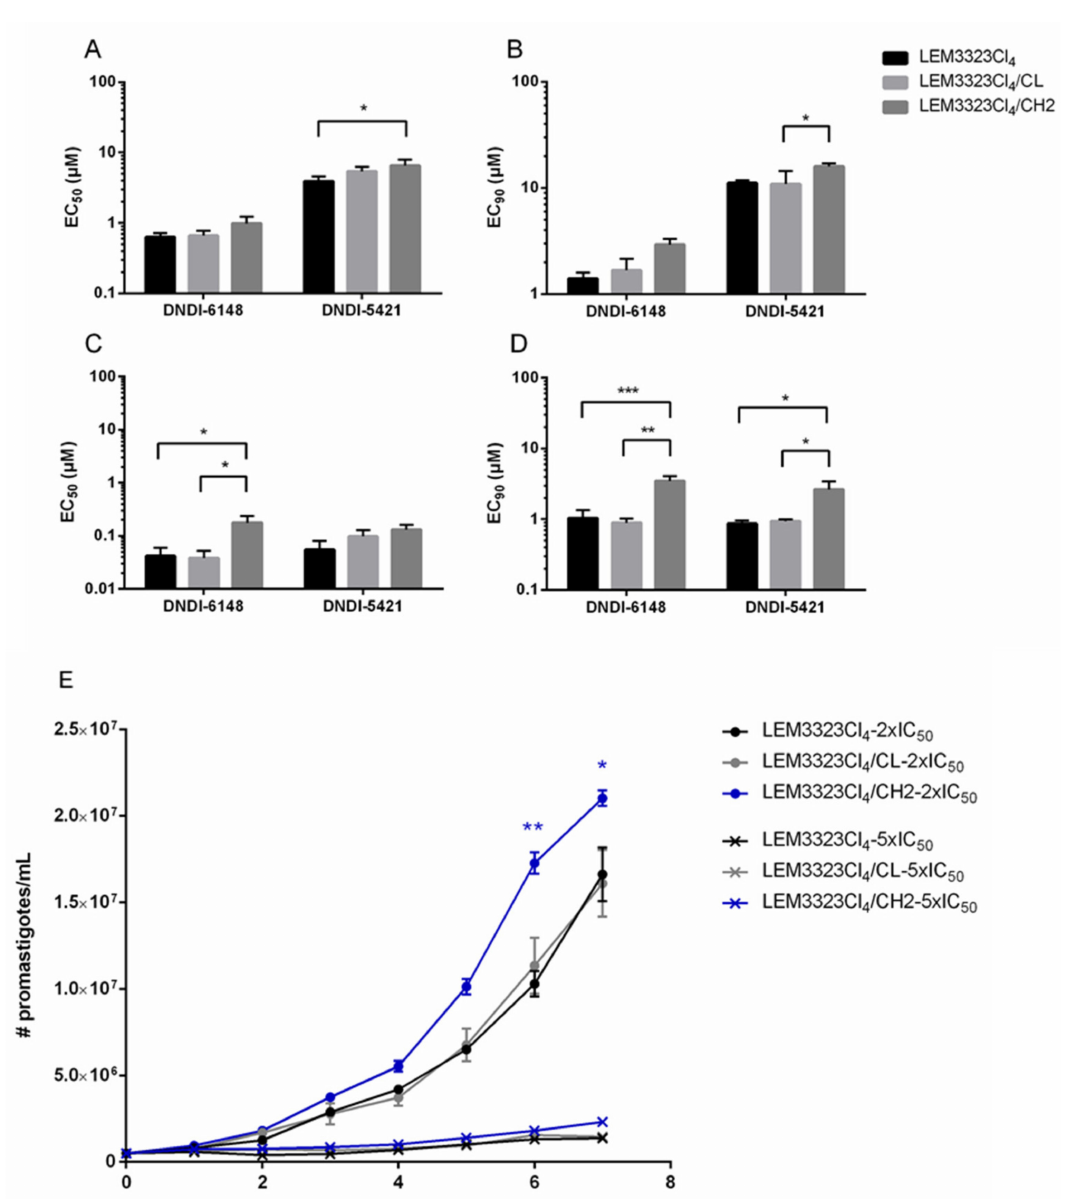
Figure 4. Susceptibility and growth curves of strains harboring either the empty cosmid (LEM3323Cl 4 /CL) or a cosmid harboring genes from chromosome 2 (LEM3323Cl 4 /CH2), compared to the wild type (LEM3323Cl 4 ). ( A , B ) Promastigote and ( C , D ) amastigote susceptibility profiles against DNDI-6148 and DNDI-5421. The EC 50 ( A , C ) and IC 90 ( B , D ) are shown. Results are expressed as the mean EC 50/90 ( µ M) ± SEM and are based on at least two independent experiments with biological duplicates. ( E ) In vitro growth curves of the strains exposed to DNDI-6148. Results are expressed as the mean number of parasites/mL ± SEM, and are based on at least two independent experiments run in duplicate. A two-way ANOVA test was performed to test significance (* p < 0.05, ** p < 0.01, *** p <